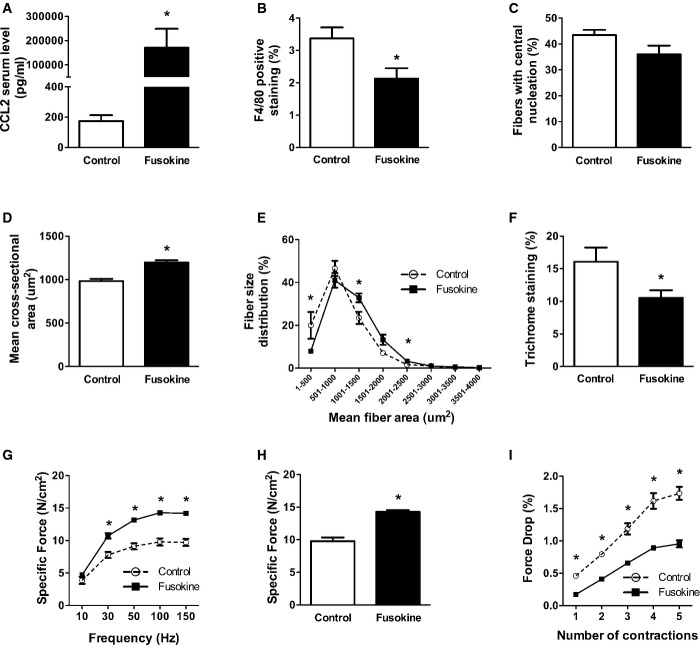
Pharmacological blockade with an anti-CCR2 fusokine ameliorates the dystrophic diaphragm phenotypeAt 6 weeks after initiation of treatment, comparisons between fusokine (n = 7) and sham (n = 5) treated mice are shown for:Fusokine protein (truncated CCL2) levels in serum, *P = 3.8e-9.Diaphragm MP infiltration, *P = 0.03.Percentage of centrally nucleated diaphragm fibers.Mean cross-sectional area of centrally nucleated fibers, *P = 0.0002.Fiber size distribution, *P = 0.03 (for 1–500 μm2), P = 0.02 (for 1,001–1,500 μm2), and P = 0.02 (for 2,001–2,500 μm2).Fibrosis quantification, *P = 0.049.Force–frequency curves during electrical stimulation of the diaphragm, *P = 0.0009 (for 30 Hz), P = 2.7e-5 (for 50 Hz), P = 1.2e-5 (for 100 Hz), and P = 8.8e-6 (for 150 Hz).Maximal force-generating capacity of the diaphragm, *P = 1.1e-5.Force drop in the diaphragm following eccentric contractions, *P = 3.1e-5 (for contraction 1), P = 4.7e-6 (for contraction 2), P = 9.2e-5 (for contraction 3), P = 6.3e-5 (for contraction 4), and P = 2.5e-5 (for contraction 5).Data information: Data are group means ± SE from three independent experiments.